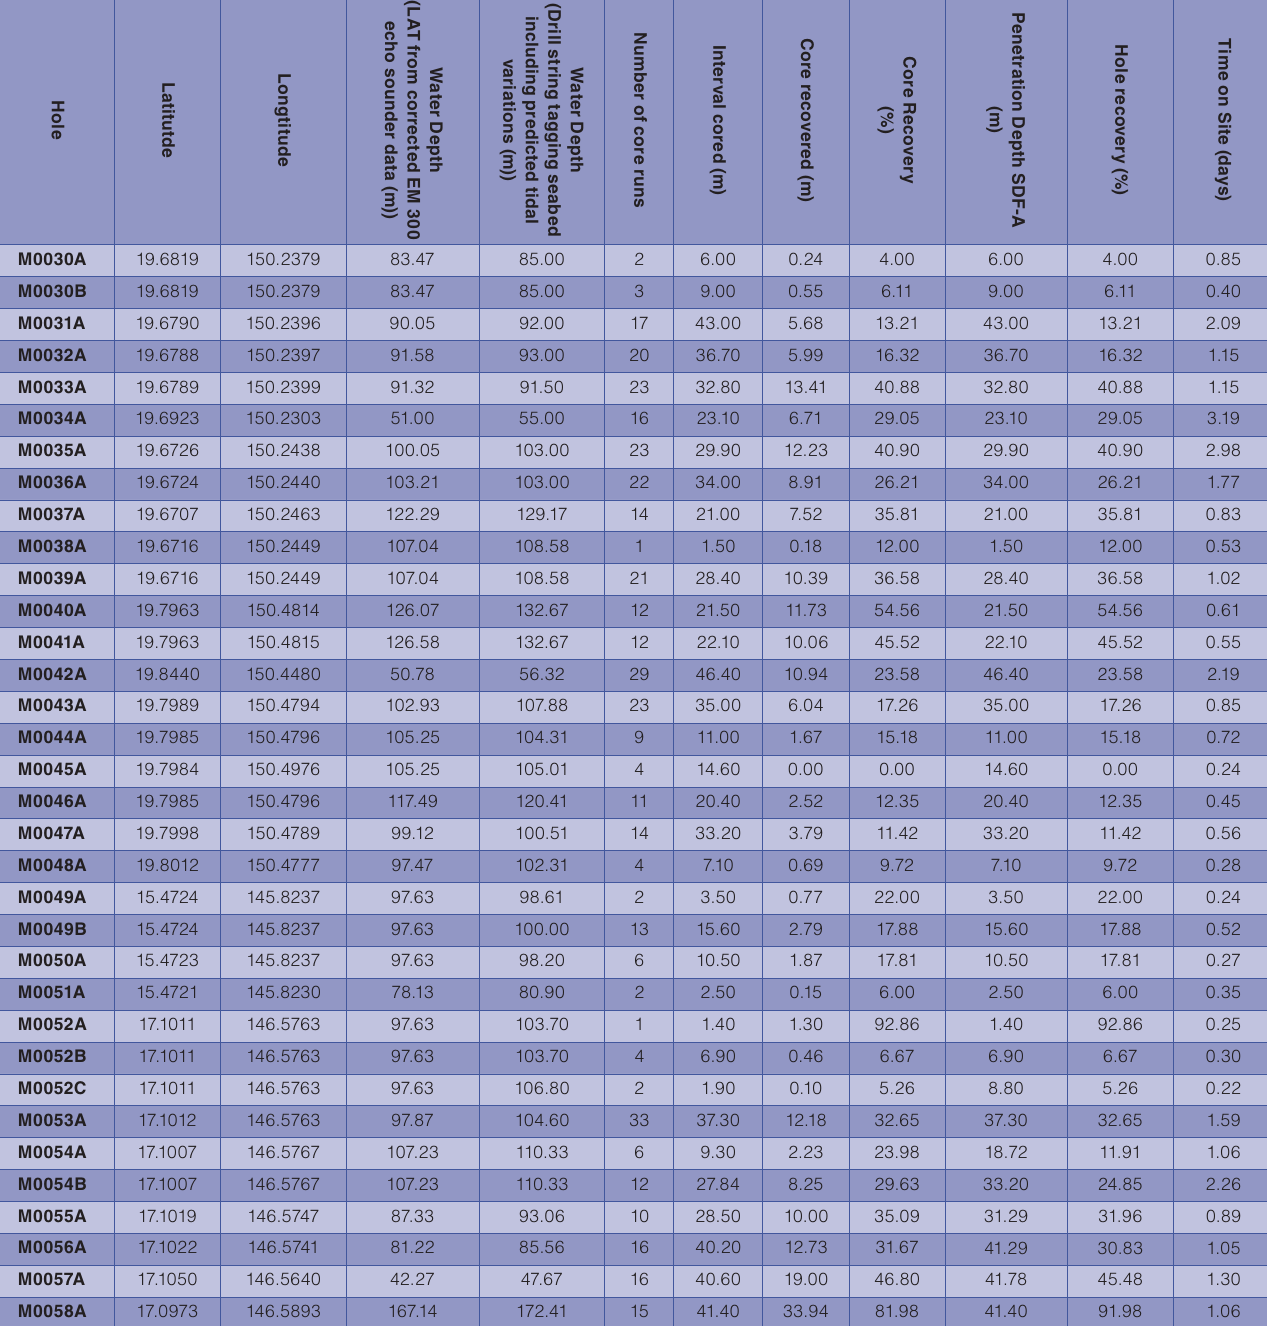
Table 1. Operational summary of IODP 325